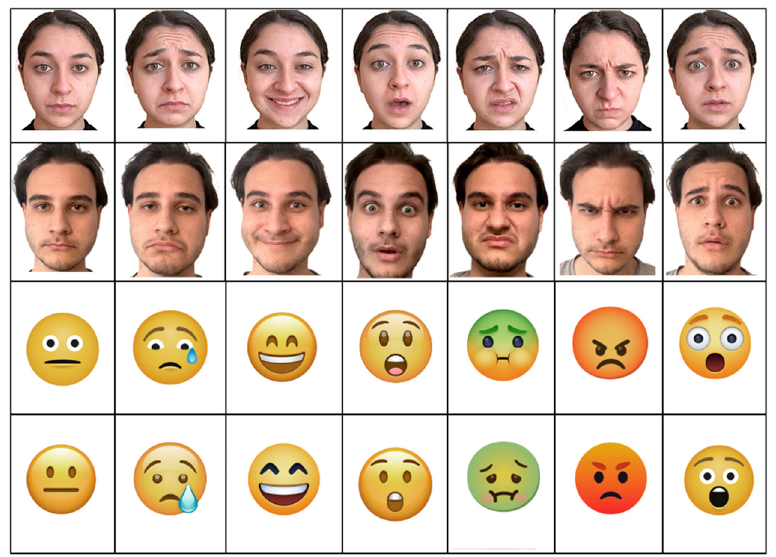
Figure 1. Examples of facial expressions and emojis used to illustrate the 7 a ff ective states, in 4 di ff erent “identities”: 1 female, 1 male, and 2 di ff erent emoji styles.